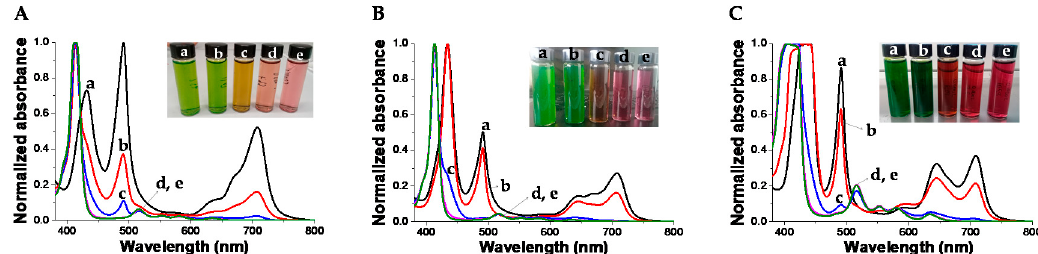
Figure 5. Normalized UV–vis spectra of TPPS at different concentration and pH in the presence of PKHEDA 1 × 10 ⁻ 4 M. ( A ) TPPS 5 × 10 ⁻ 5 M and pHs: (a) 2.57, (b) 4.07, (c) 6.28, (d) 7.95, (e) 10.89. ( B ) TPPS 1 × 10 ⁻ 4 M and pHs: (a) 2.33, (b) 3.72, (c) 6.26, (d) 7.85, (e) 11.13. ( C ) TPPS 2 × 10 ⁻ 4 M pHs: (a)